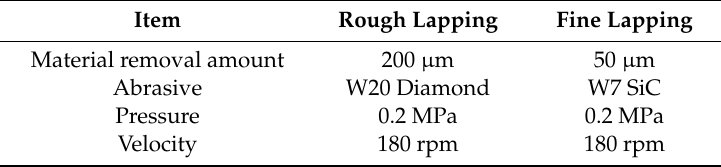
Table 3. Parameter of optimum lapping